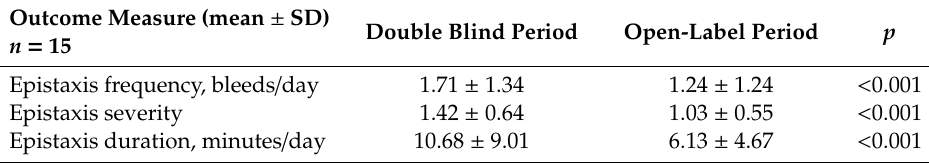
Table 6. Diary outcome measures in the open label phase, diary